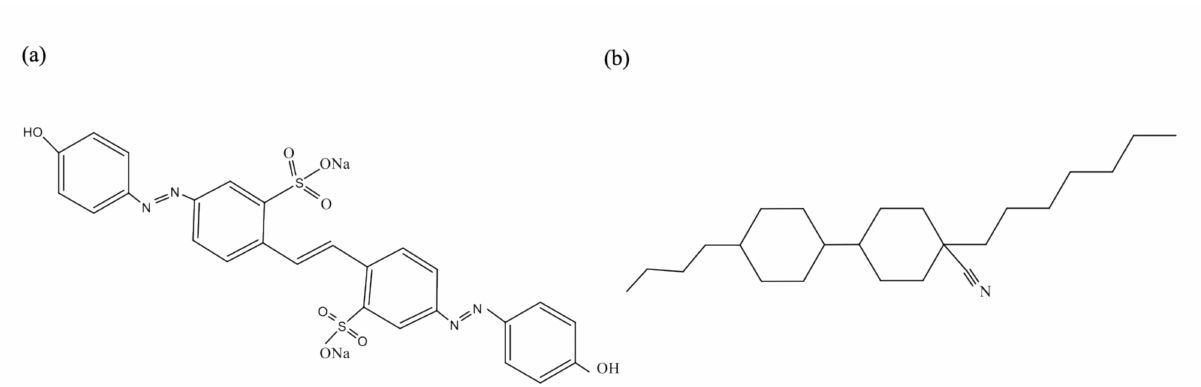
Figure 1. Chemical Structure of the materials ( a ) Photoresponsive azo-dye Brilliant Yellow, ( b ) liquid crystal